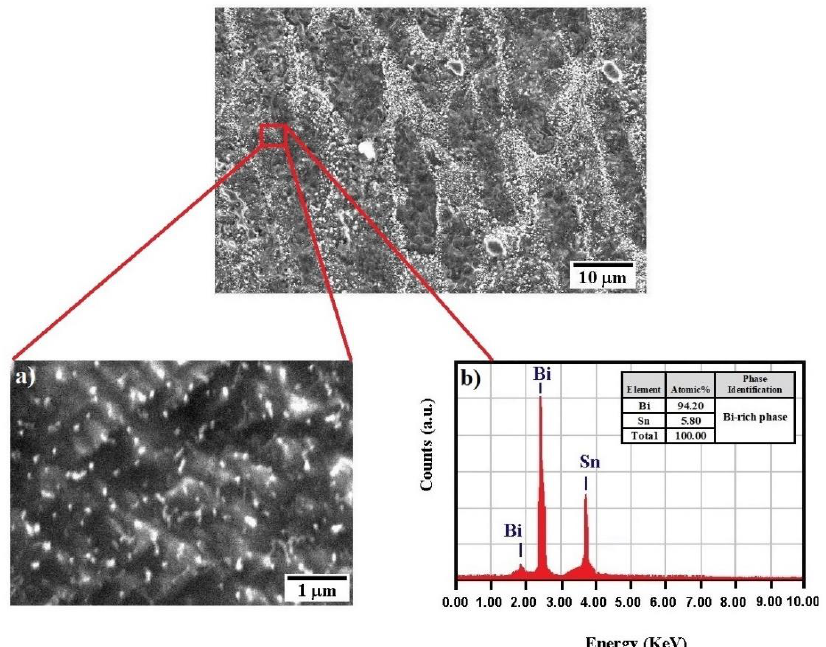
Figure 8. Representative SEM micrograph of SAC105-3.5Bi solder aged at 353 K: ( a ) enlarged SEM of Bi particles, and ( b ) EDS spectra of Bi particles.